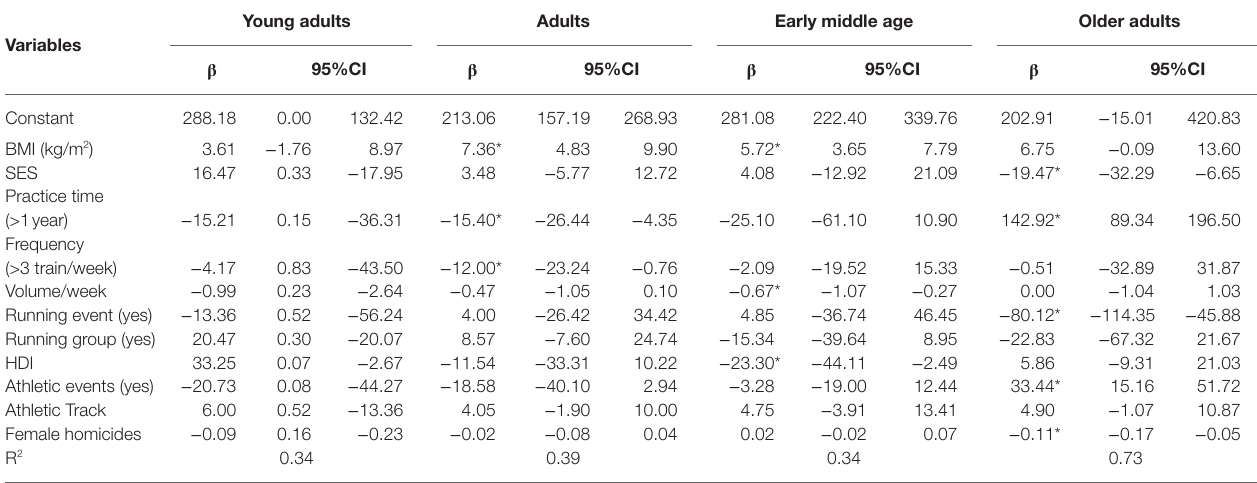
TABLE 2 | Results to linear regression clustered by state, considering age group.